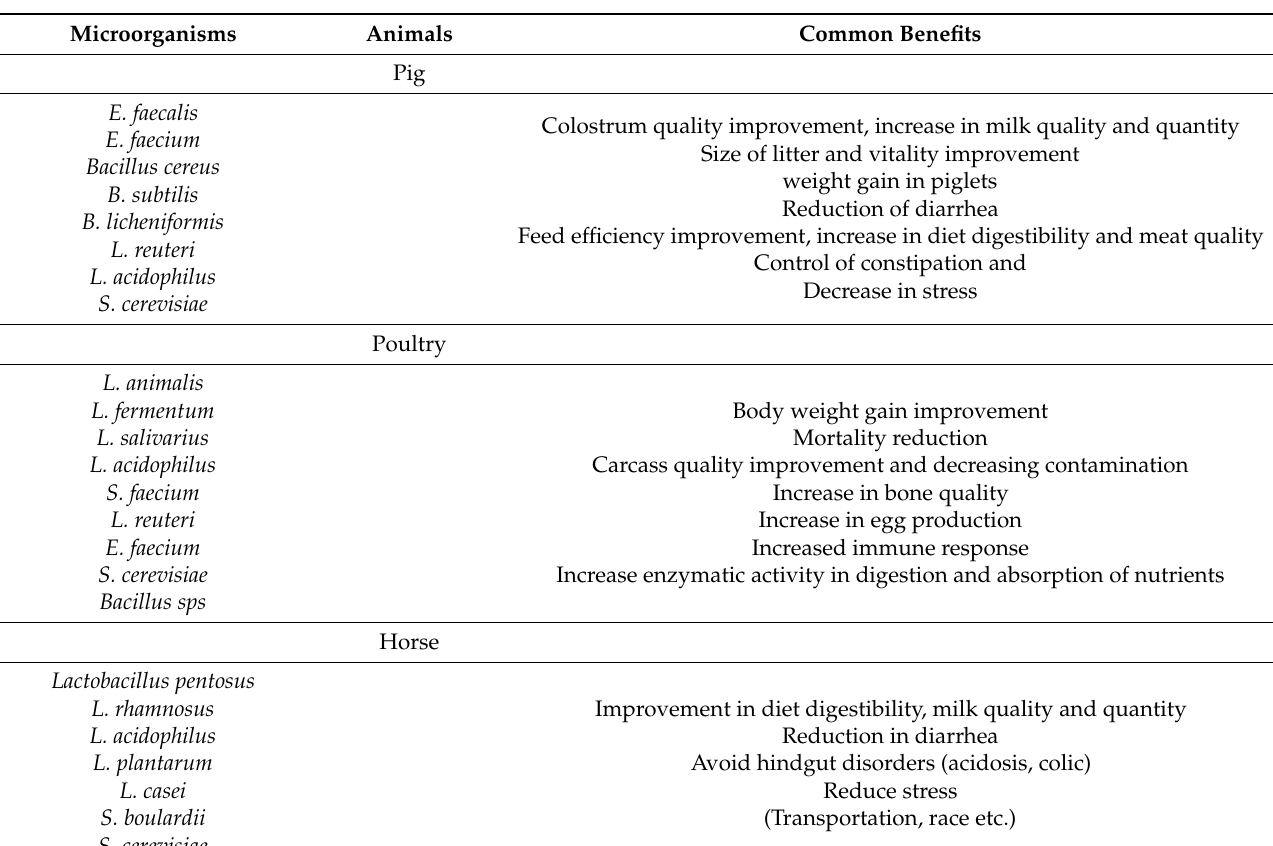
Table 1. Some common probiotic bacteria and their benefits in monogastric